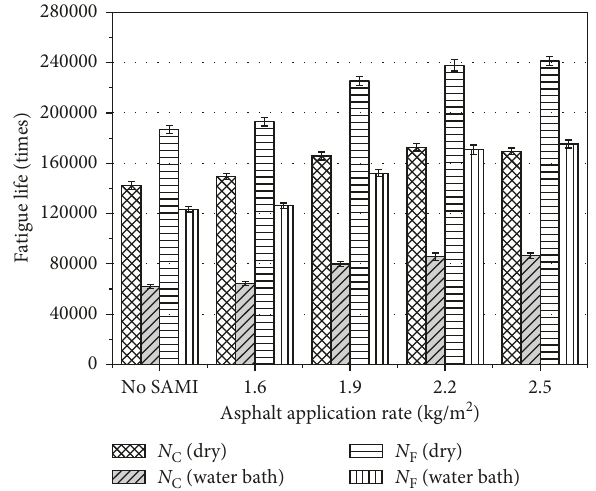
Figure 11: Fatigue cracking test results under the dry condition of 15 ° C.